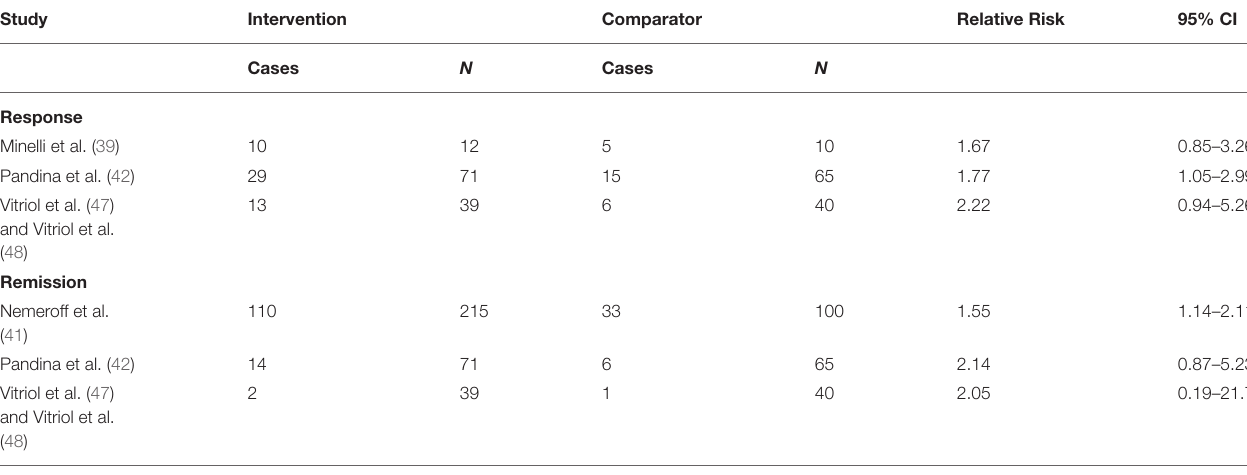
TABLE 5 | Short-term response to treatment and remission of depressive symptoms.